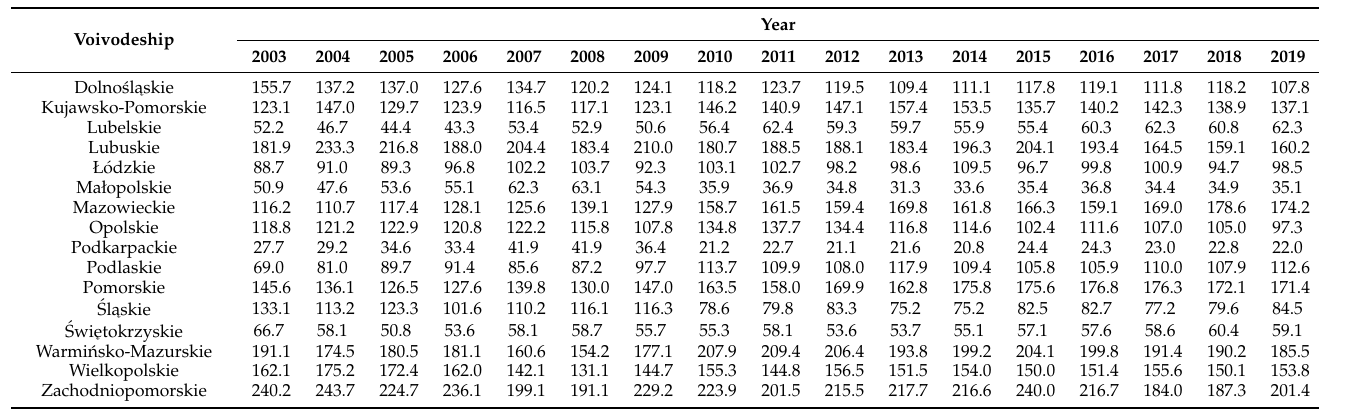
Table 2. Distribution dynamics of the gross value added per person working in relation to the country (in %) 1 .